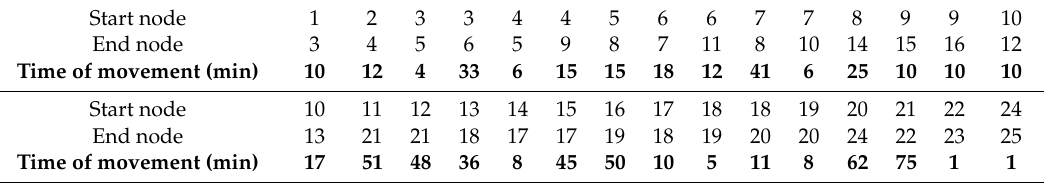
Table 1. Time of miners movement in A mine (own